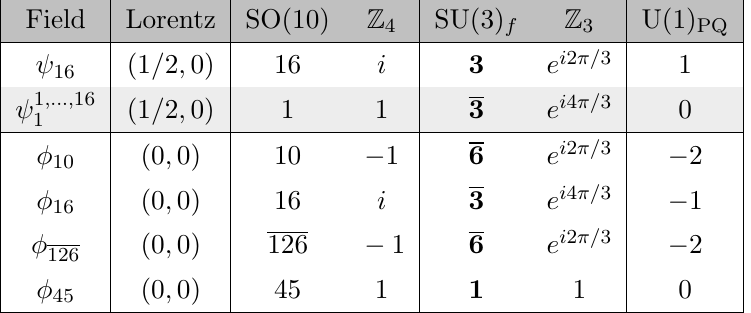
SU(3) f , (cid:2) 3 f